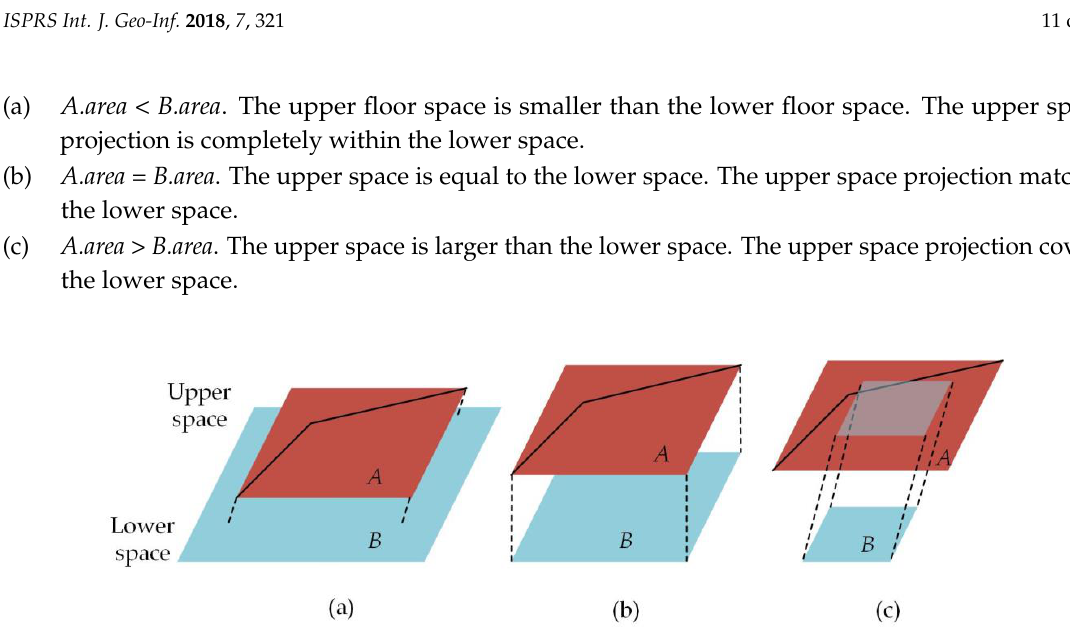
Figure 12. Space area relationships between the upper and lower floors: ( a ) 𝐴.𝑎𝑟𝑒𝑎 < 𝐵.𝑎𝑟𝑒𝑎 , ( b ) 𝐴.𝑎𝑟𝑒𝑎 = 𝐵.𝑎𝑟𝑒𝑎 , and ( c ) 𝐴.𝑎𝑟𝑒𝑎 > 𝐵.𝑎𝑟𝑒𝑎 . 𝐴.𝑎𝑟𝑒𝑎 is the upper indoor space area, and 𝐵.𝑎𝑟𝑒𝑎 is the lower space area.